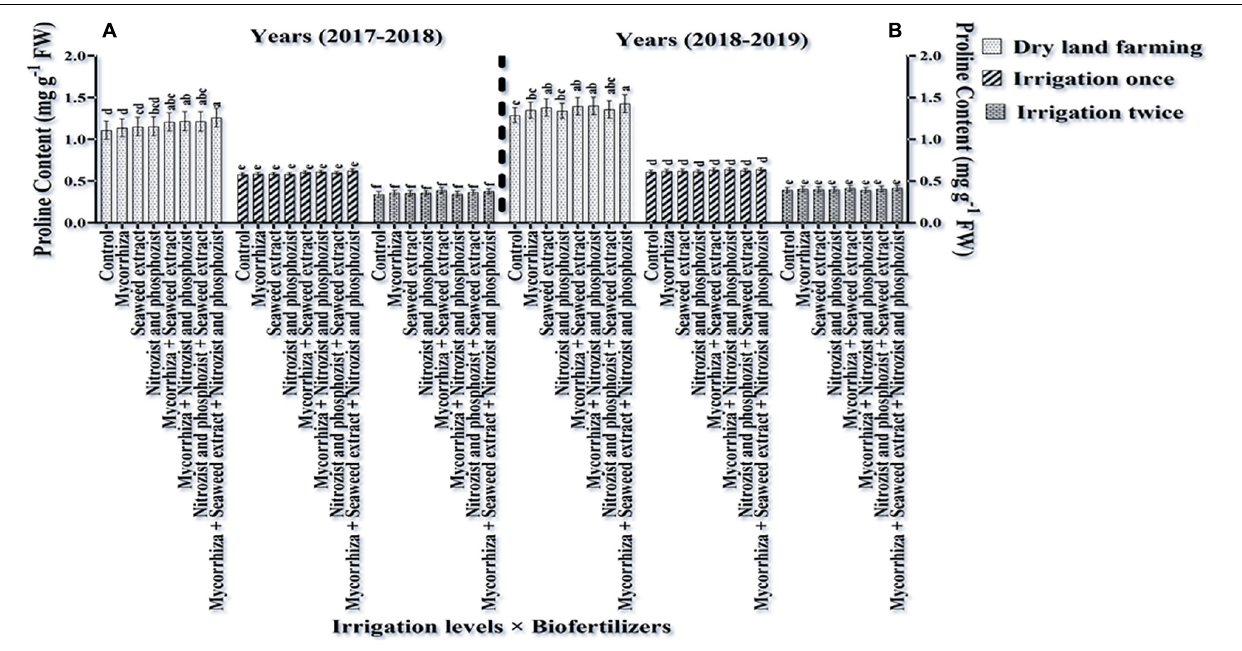
FIGURE 7 | Mean comparisons of the dual interaction effect of irrigation × biofertilizers on proline content of wheat plant in two seasons of experiment (A,B) (2017–2018 and 2018–2019). Means in each column followed by similar letter(s) are not significantly different at 1% probability level by the LSD